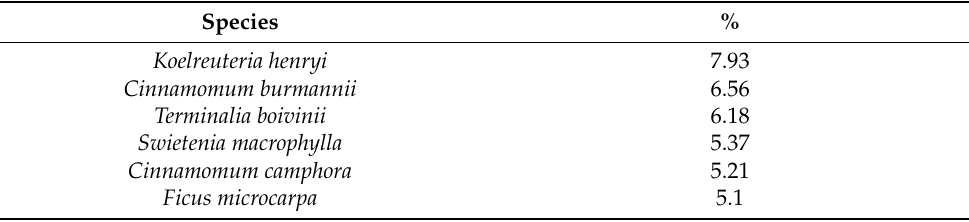
Table 2. Tree species with individual numbers exceeding 5% of the total number of trees